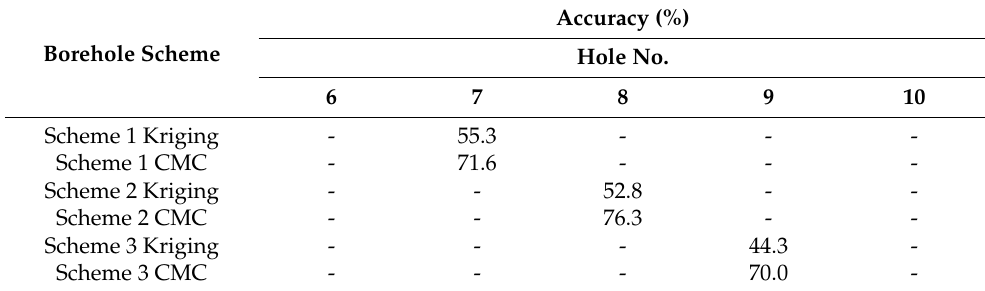
Table 6. Comparison of the accuracy of the Kriging and CMC methods (100 cyc.).